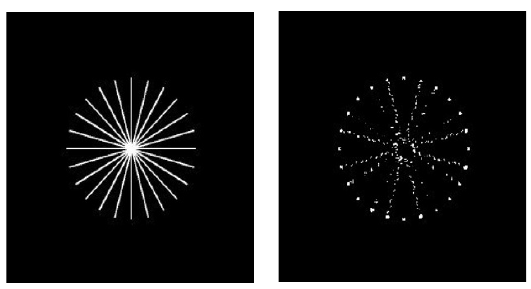
Figure 2: Bottom-up detection of interest points. The figure illus- trates the end-stopping (termination detector) properties of the ap- proach.